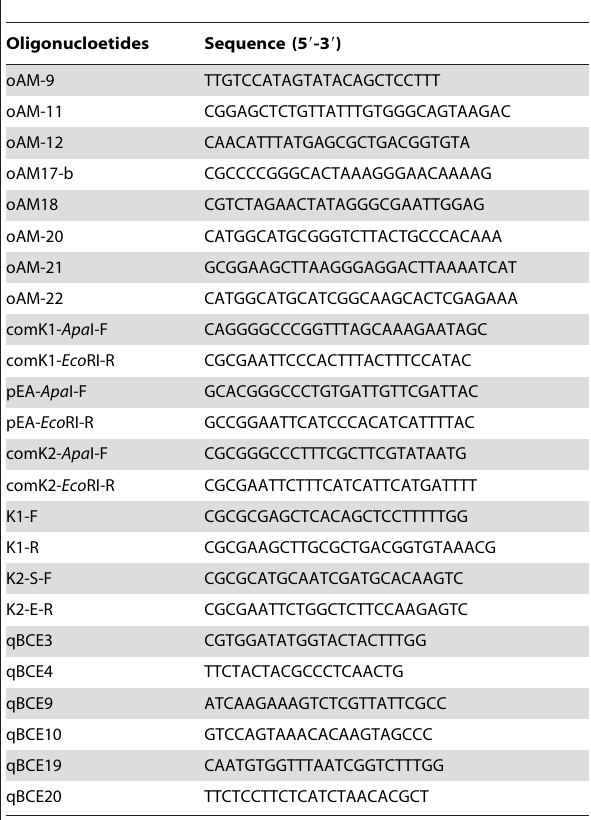
Table 4. Oligonucleotides used in this